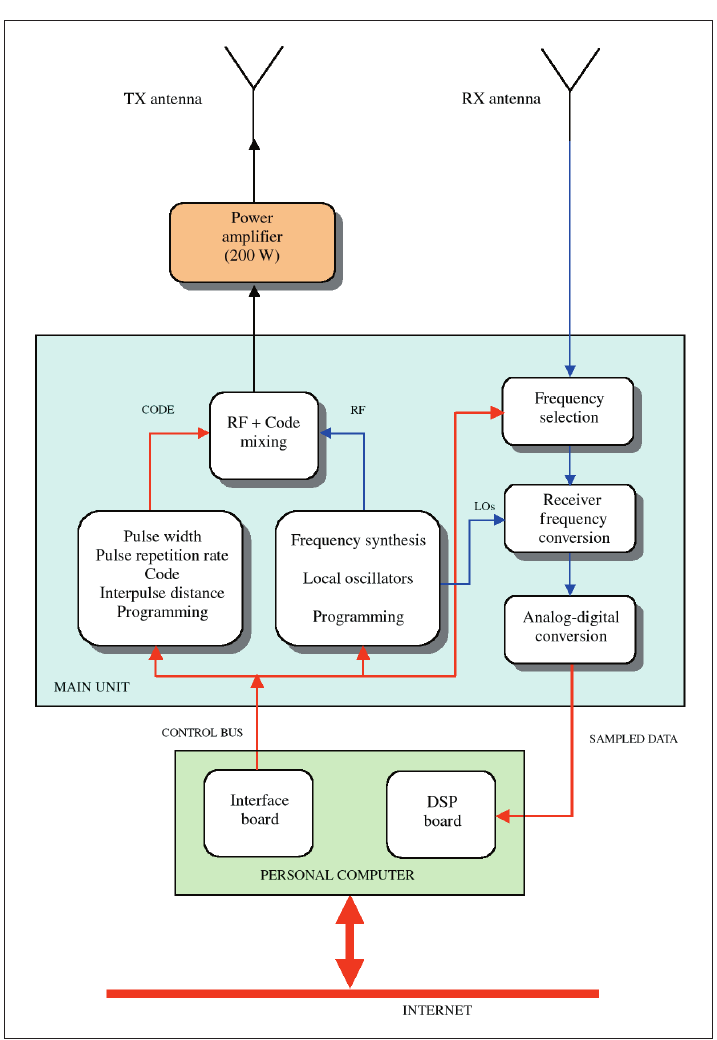
Fig. 1. Block diagram of the AIS-INGV ionosonde: red lines are digital signals while blue lines are